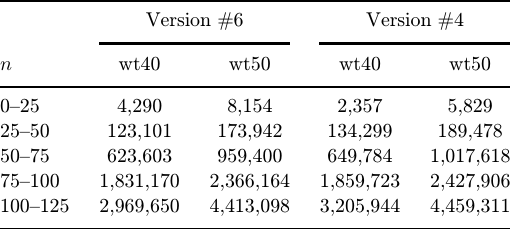
Table 4. Comparison between AIT (Version #4) and AIT-S (Version #6).